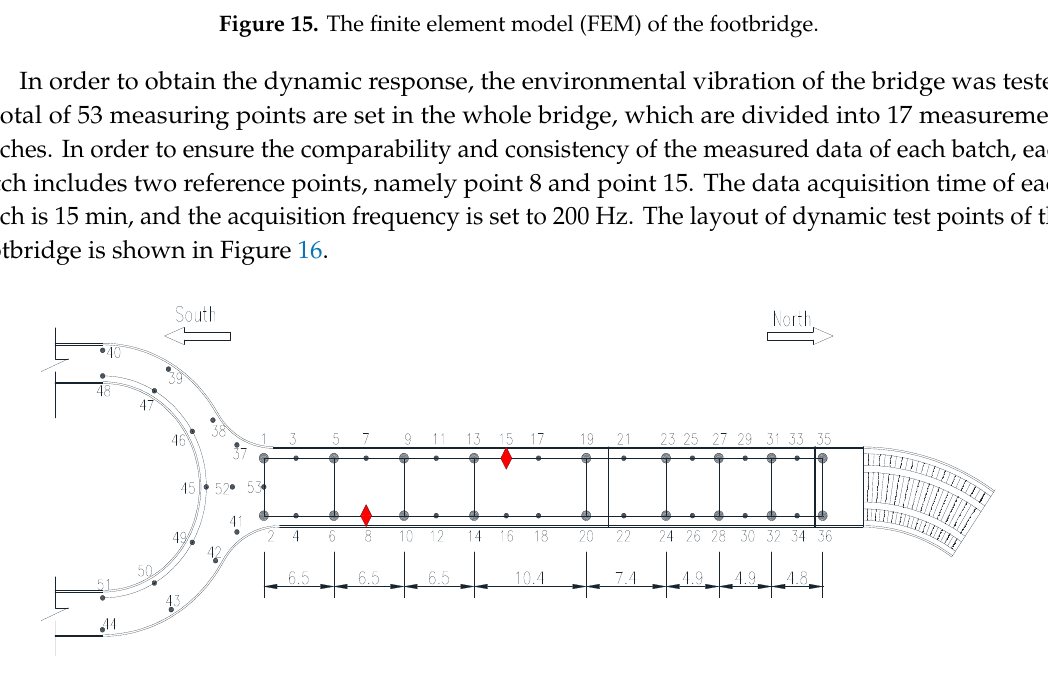
Figure 16. Layout of dynamic test points of footbridge (unit: m).